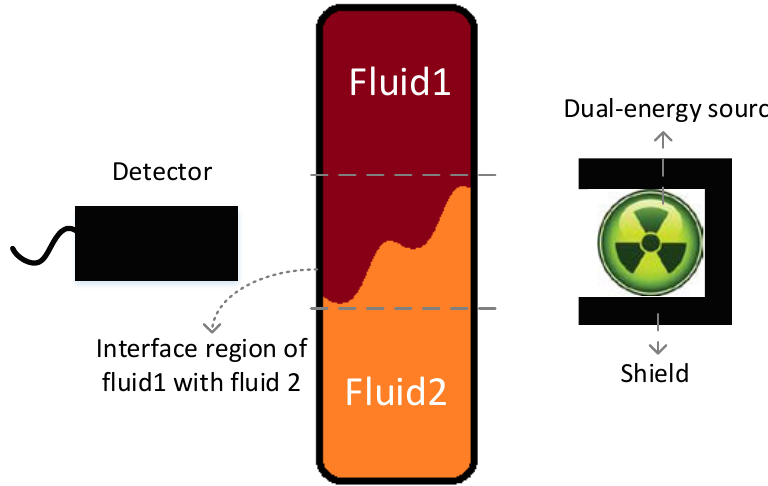
Figure 1. Simulation structure.